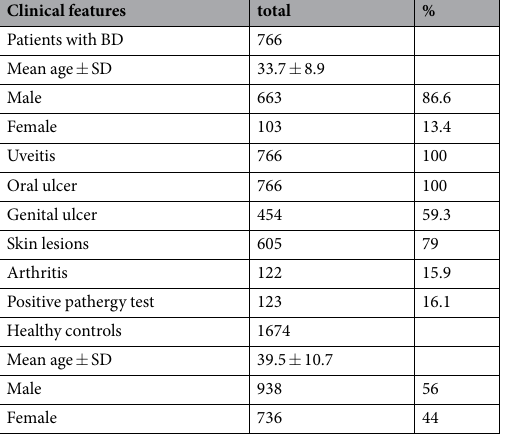
Table 1. Clinical features, age, and sex distribution of BD patients and healthy